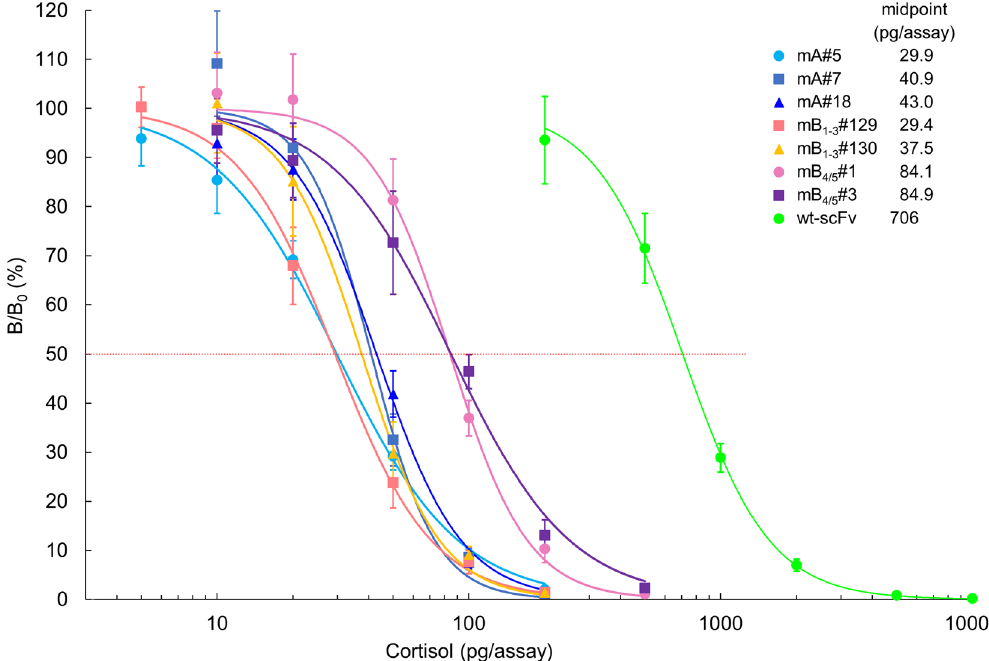
Figure 5. Typical dose–response curves for cortisol in competitive ELISAs using wt-scFv and the improved scFvs. The vertical bars indicate the SD for intra-assay variance ( n = 4). The midpoint values (pg/assay)